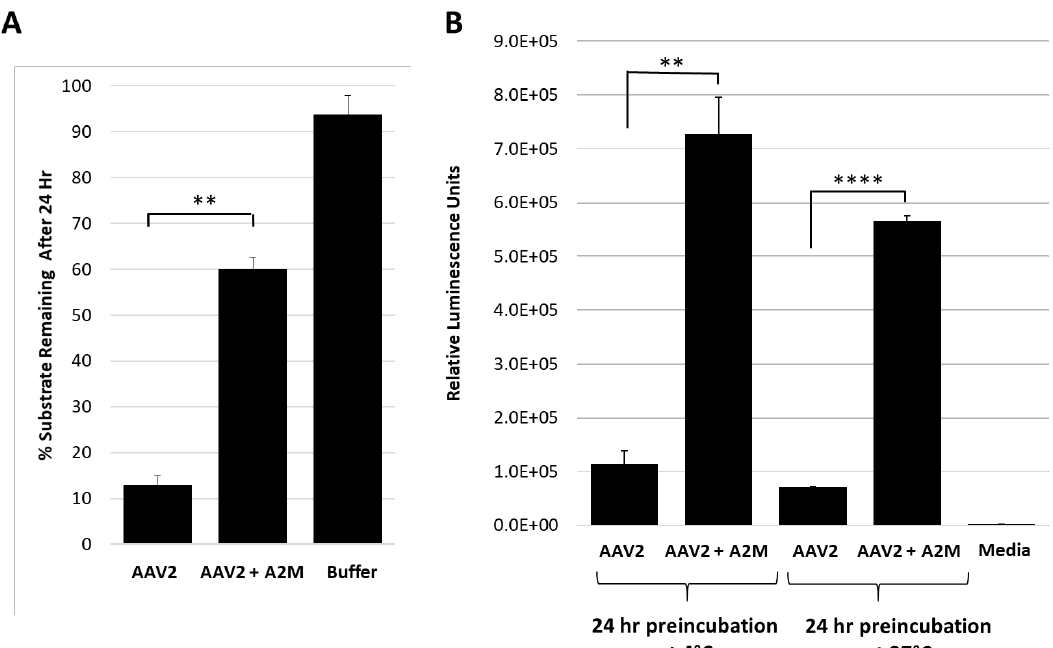
Figure 3. Alpha-2-macroglobulin inhibits protease function and correlates with increased cellular transduction. ( A ) AAV2 protease function inhibition in presence of A2M. The y -axis shows the amount of casein substrate remaining after 24 h at the conditions indicated ( x -axis). ( B ) Luciferase gene expression ( y -axis in relative luminescence units) for AAV2 with or without A2M ( x -axis) prior to cell infection. Statistical significance as indicated by asterisk annotations (*) are described in Material and Methods